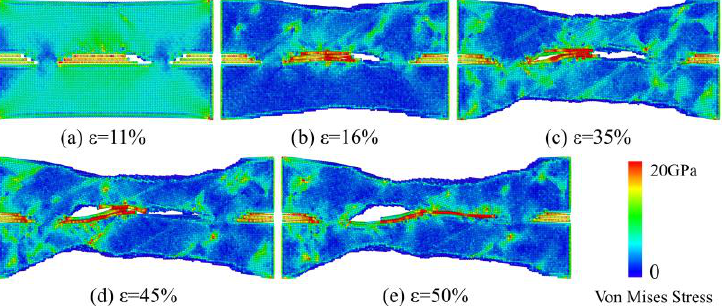
Figure 19. Crystal structure and dislocation line distribution of Gr/Cu-3 under different strains. ( a ) ε = 11%, ( b ) ε = 16%, ( c ) ε = 35%, ( d ) ε = 45% and ( e ) ε = 50%.